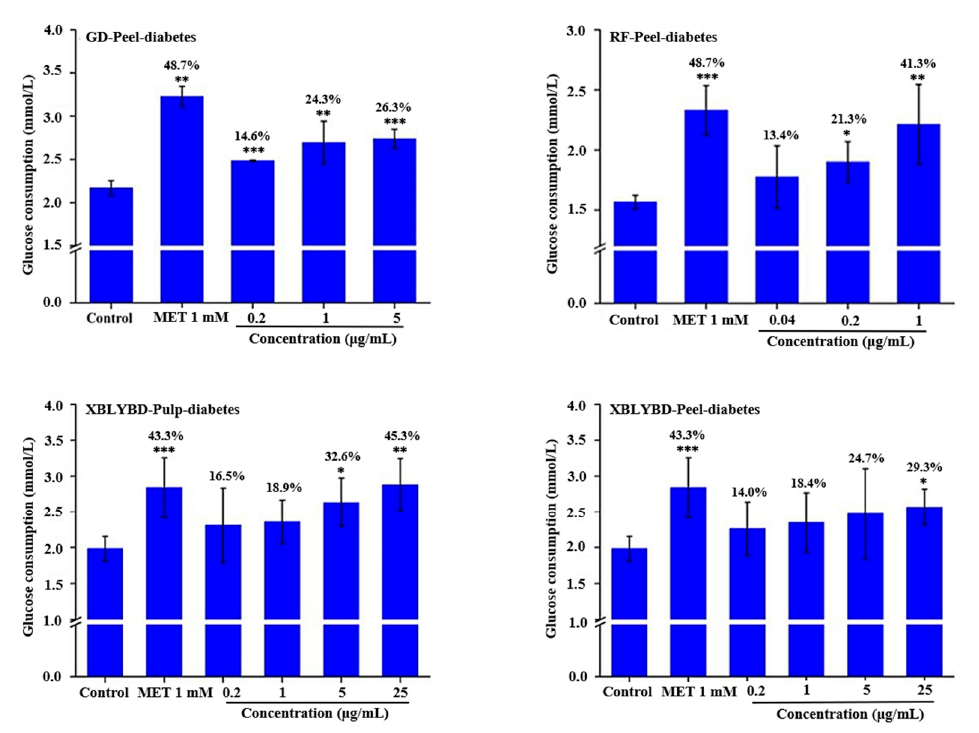
Figure 10. Effect of apple extracts on glucose consumption in HepG2 cells.The names of apple cultivars were showed as abbreviations: XBLYBD for ‘Xiboliyabaidian’, RF for ‘Red Fuji’, GD for ‘Gold Delicious’. * indicated significant differences at the 0.05 probability level, ** indicated significant differences at the 0.01 probability level, and *** indicated significant differences at the 0.001 probability level compared to the control group without treating with apple extract using t test.